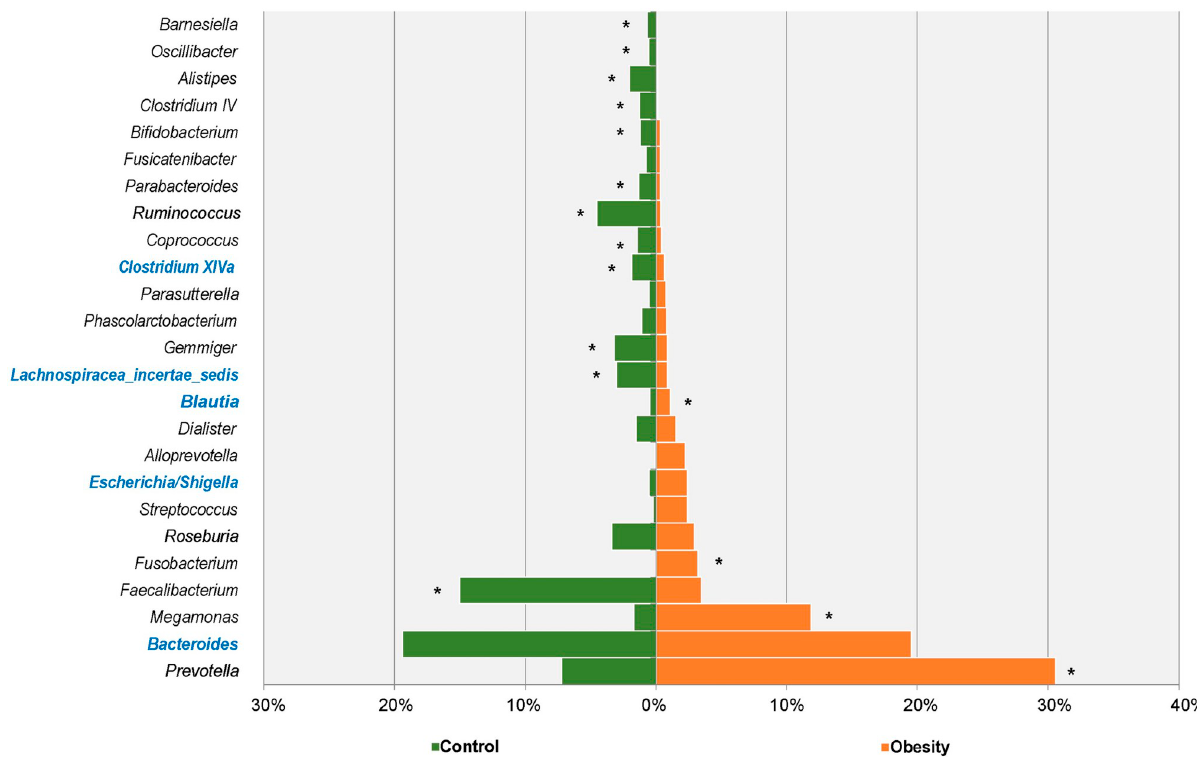
Fig 4. Major abundant genera in Obesity and Control groups. The genera with significant richness differences between the two groups were labeled with an